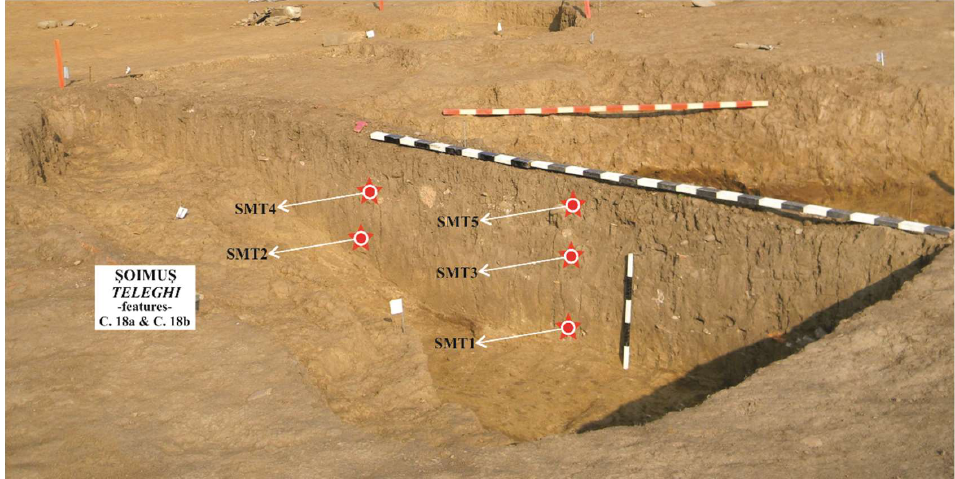
Figure 3. Phytolith samples localisation in the features C.18a and C.18b—site Şoimuş-Teleghi .